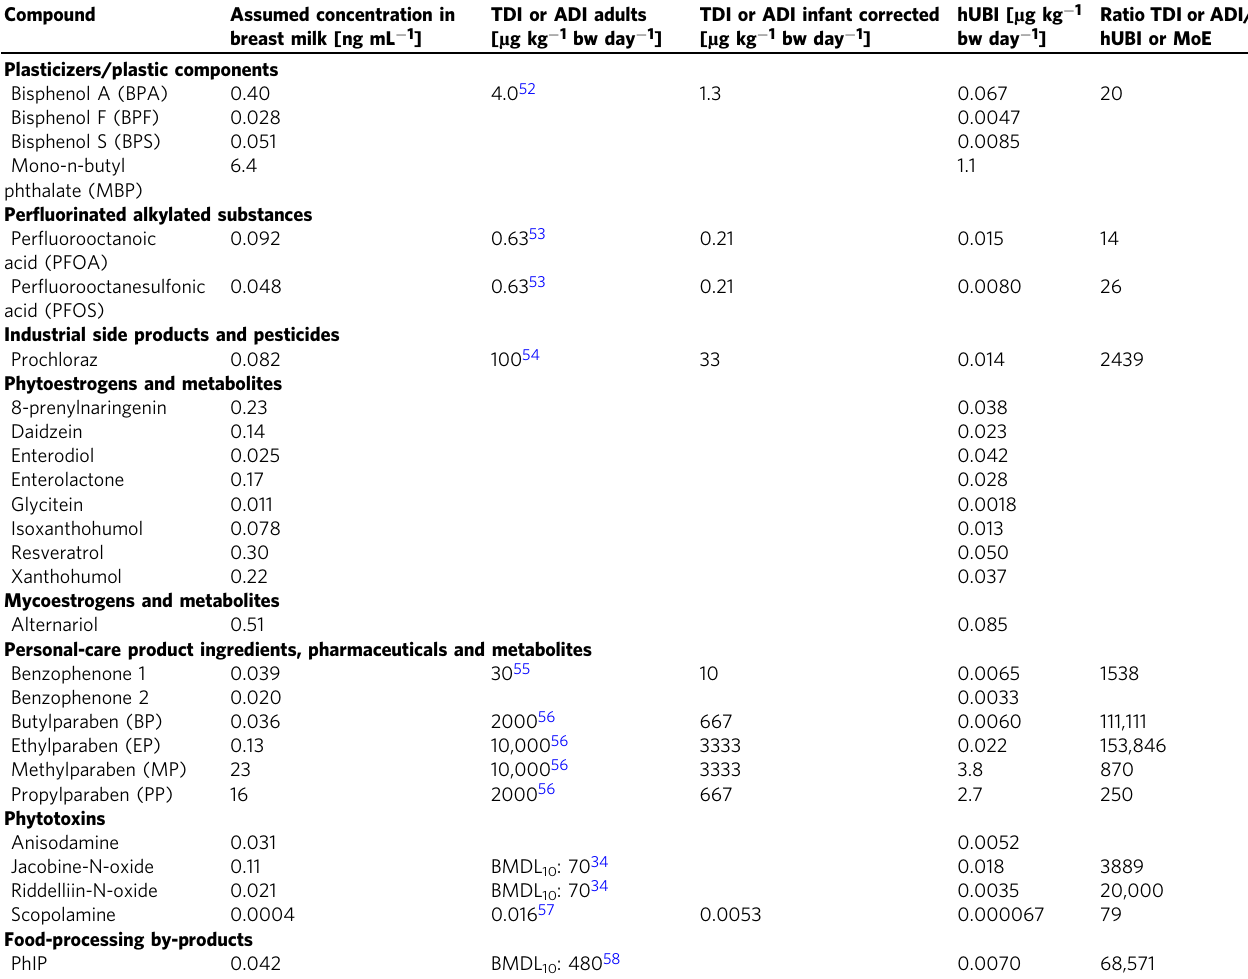
Table 2 Preliminary exposure/risk assessment using a high-exposure scenario.